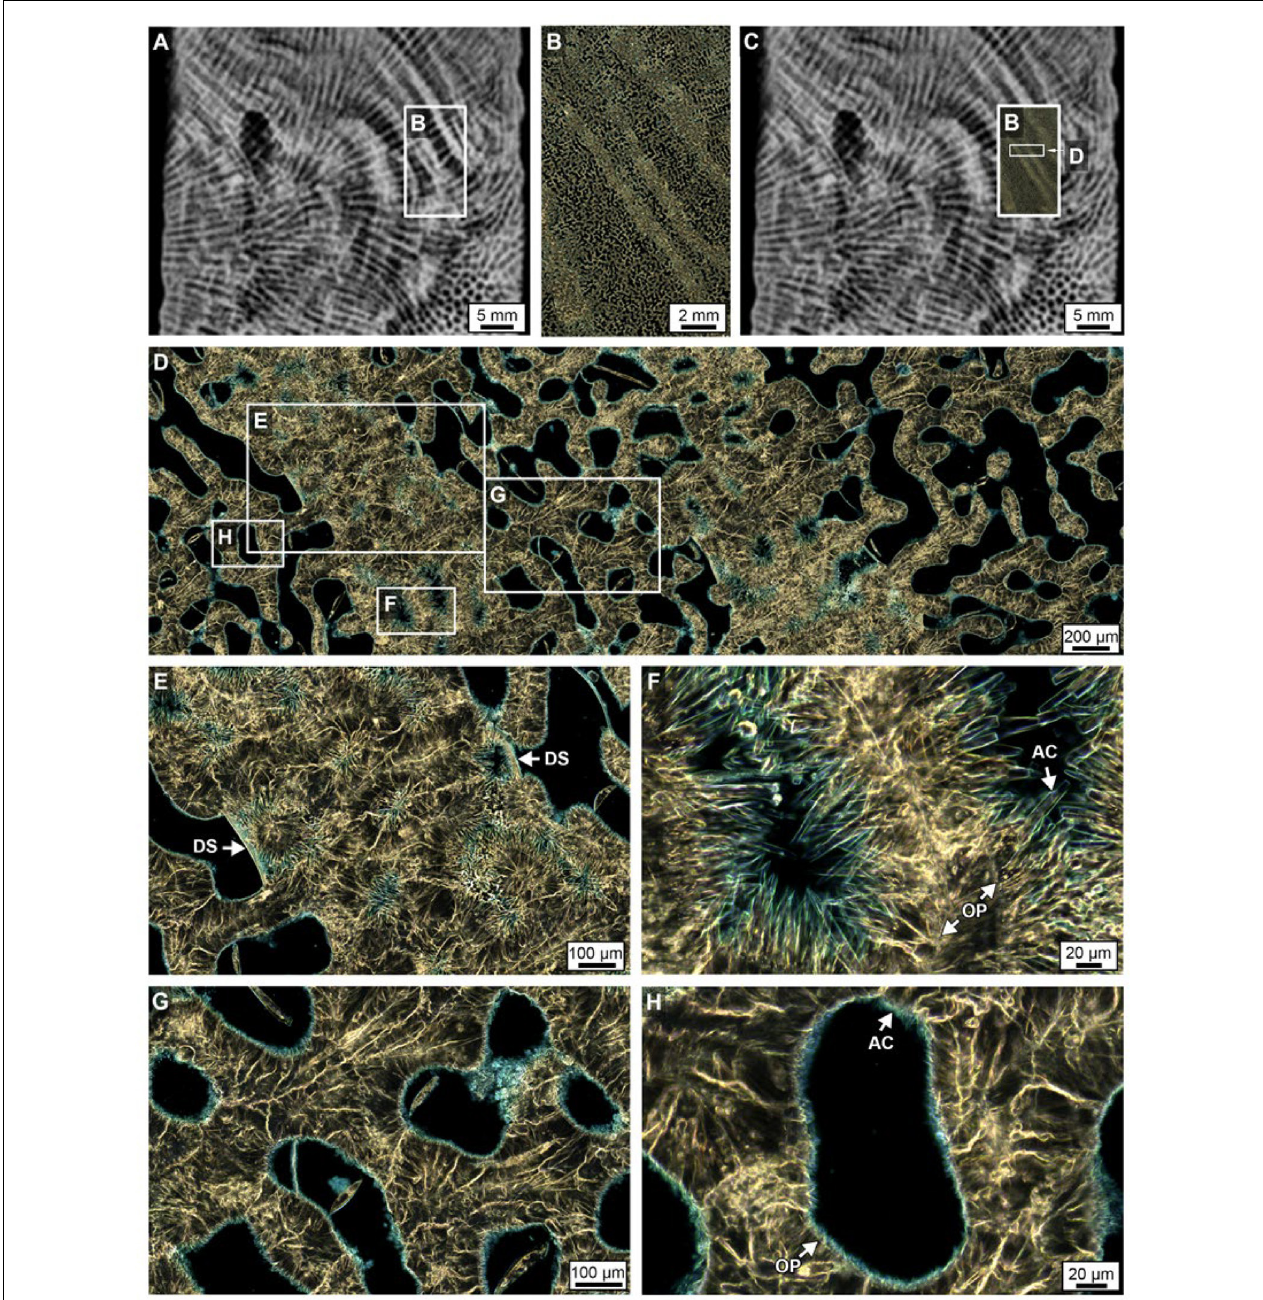
FIGURE 6 | Crystalline structure of high- and low-density bands (HDBs and LDBs) within the lowermost 6 cm of Core 3. (A–C) Overlay of a ring aperture contrast (RAC) image on an XRD showing the precise location of coral skeletal density banding (CSDB) on the thin section. (D) RAC image of HDBs and LDBs in which HDBs exhibit abundant pore space with diagenetic aragonite cements (AC). (E) HDB with dissepiments (DS) bounding AC. (F) AC crystals grow from OP into pore space. (G,H) High porosity LDB with minimal AC growing inward from the outer pore surface